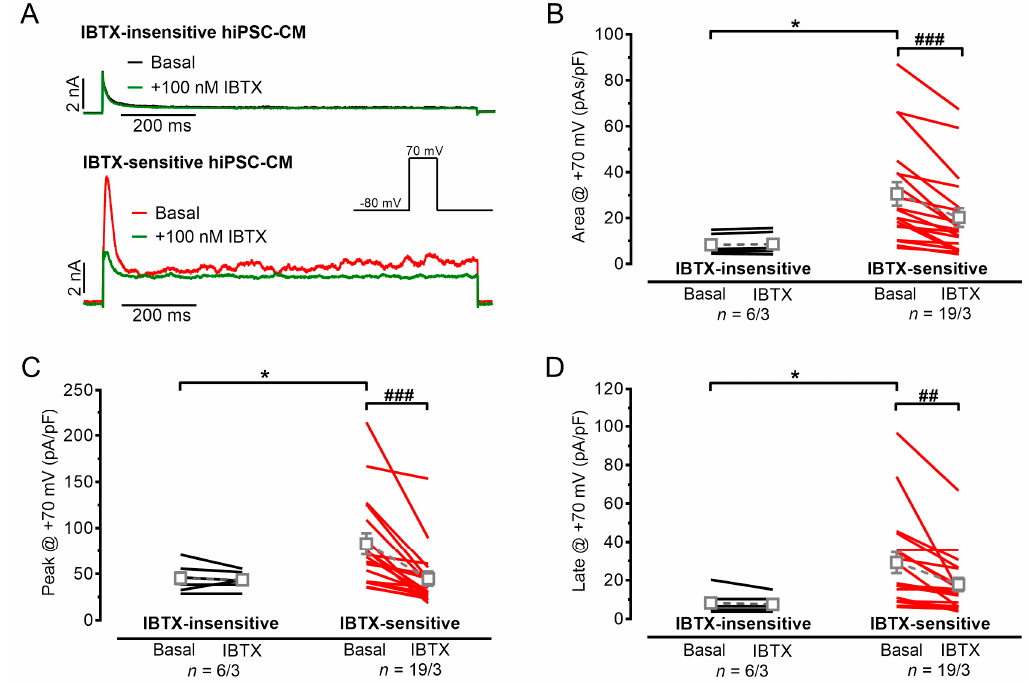
Figure 1. Outward currents in C25 human induced pluripotent stem cell-derived cardiomyocytes (hiPSC-CMs) and the effect of iberiotoxin (IBTX). ( A ) Original outward traces before (black) and after (green) exposure of 100 nM IBTX in insensitive (upper, black directly underlying green curve) and sensitive (lower panel) hiPSC-CMs. ( B – D ). Summary of IBTX (100 nM) effects in insensitive (left panel) and sensitive (right panel) hiPSC-CMs quantified by area under the curve ( B ), peak current ( C ) and current at the end of the test pulse (late current, D ). Mean values ± SEM. * p < 0.05, unpaired Student’s t test for basal values in insensitive vs. sensitive hiPSC-CMs; ## p < 0.01, ### p < 0.001; paired Student’s t test for basal vs. IBTX; n = number of isolated cells/number of individual differentiation batches.